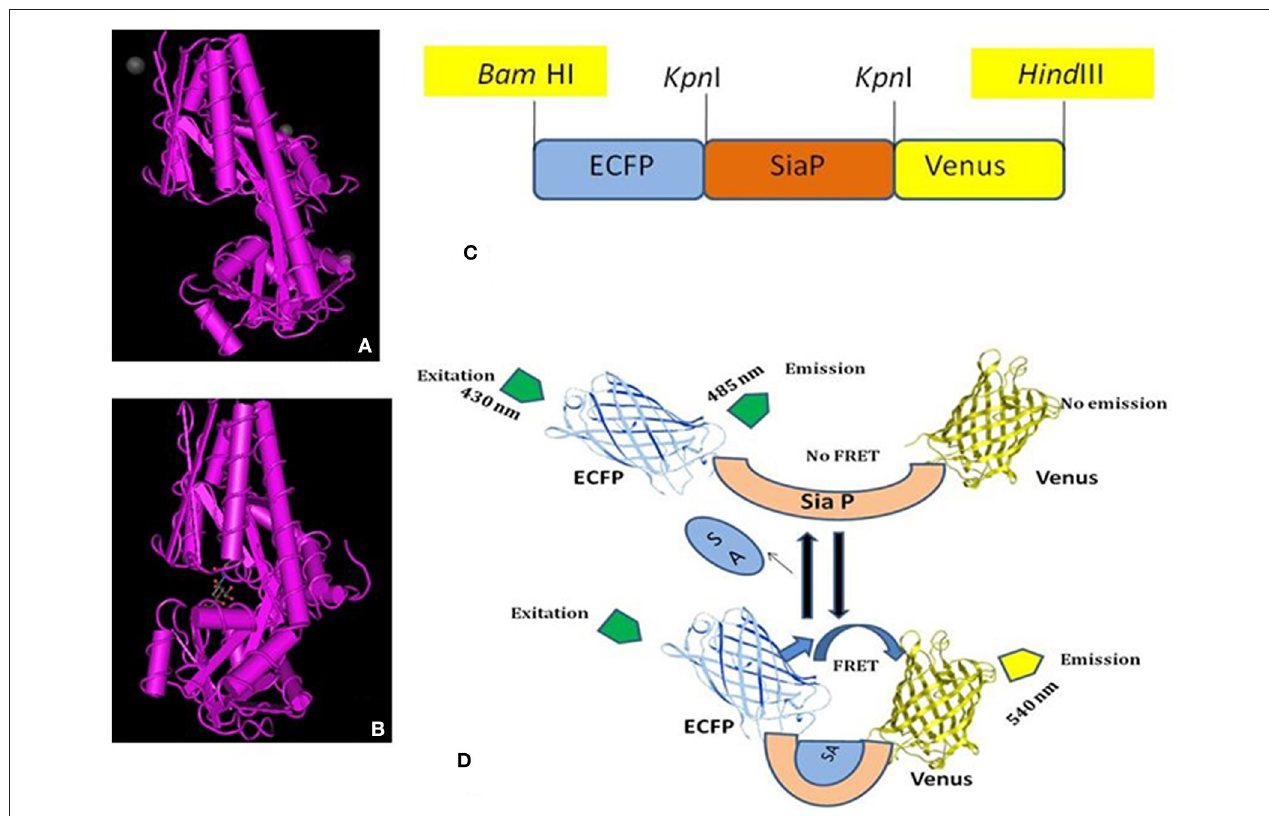
FIGURE 1 | NeuAc nanosensor. (A) Open form of SiaP protein, (B) Closed form of SiaP protein (26, 27), (C) Diagram represents the restriction sites of ECFP-SiaP-Venus construct, (D) General demonstration of working of FLIP-SA. Addition of NeuAc with the sensory domain (SiaP) brings the ECFP and Venus closure, resulting the